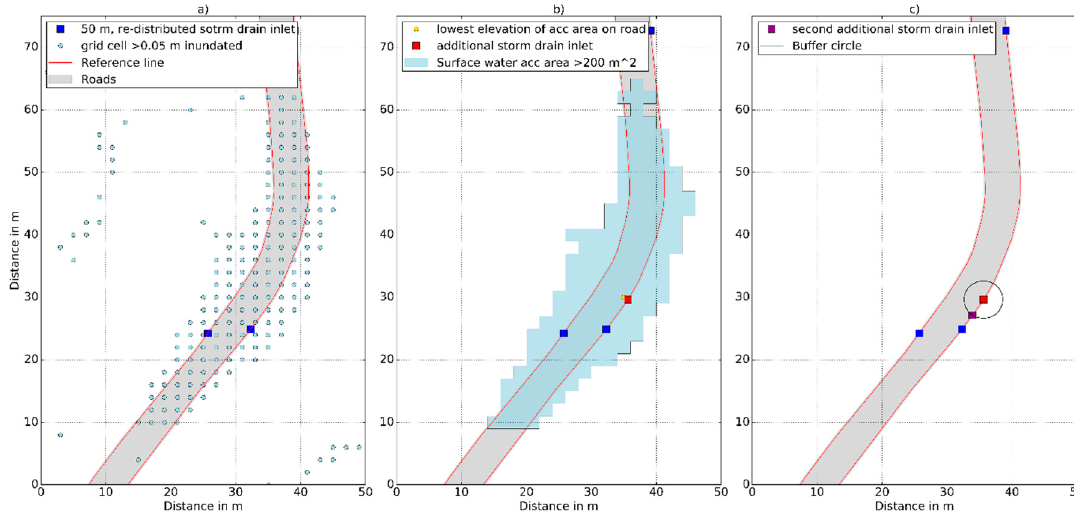
Figure 7. Placement of additional twin storm drain inlets in surface water accumulation areas. Extracted cells with inundation depth >0.05 m ( a ) are accumulated and converted to polygons ( b ). For each polygon >200 m 2 and intersecting with reference line the lowest elevation point inside the road polygon is identified and two additional inlets are placed ( b , c ). All four storm drain inlets shown in ( c ) are applied for hydrodynamic simulation in CityCAT 1D/2D.